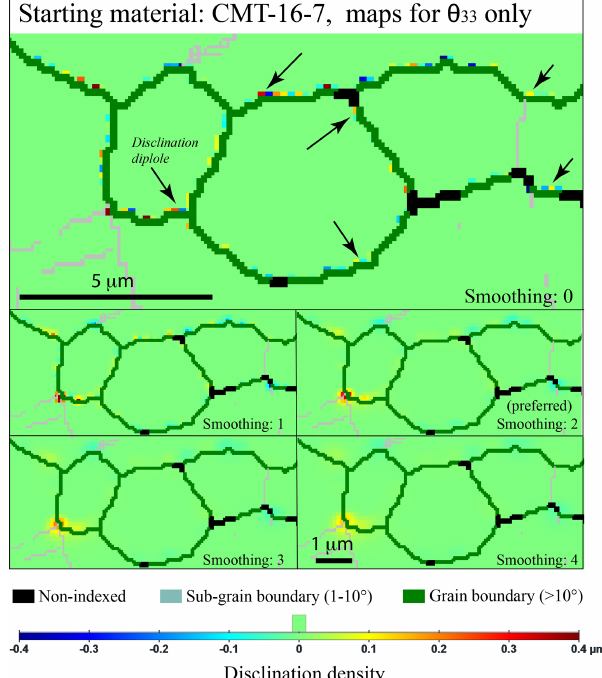
Figure 2. Comparison of wedge disclination densities θ 33 with dif- ferent smoothing factors of 0, 1, 2, 3, and 4, for a selected area (top left corner) of the starting-material map (sample CMT-16-7). A user-defined scale was used here; the step size was 0.1µm, and the range of disorientation for disclination detection was 0–10 ◦